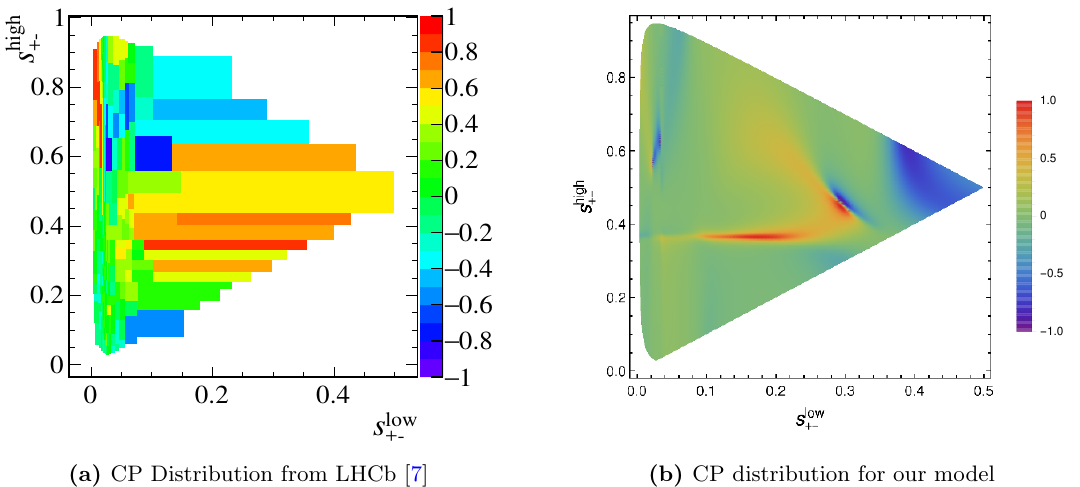
Figure 6. CP distribution for (a) the LHCb data [7] and (b) our model including the charm- resonance structure of